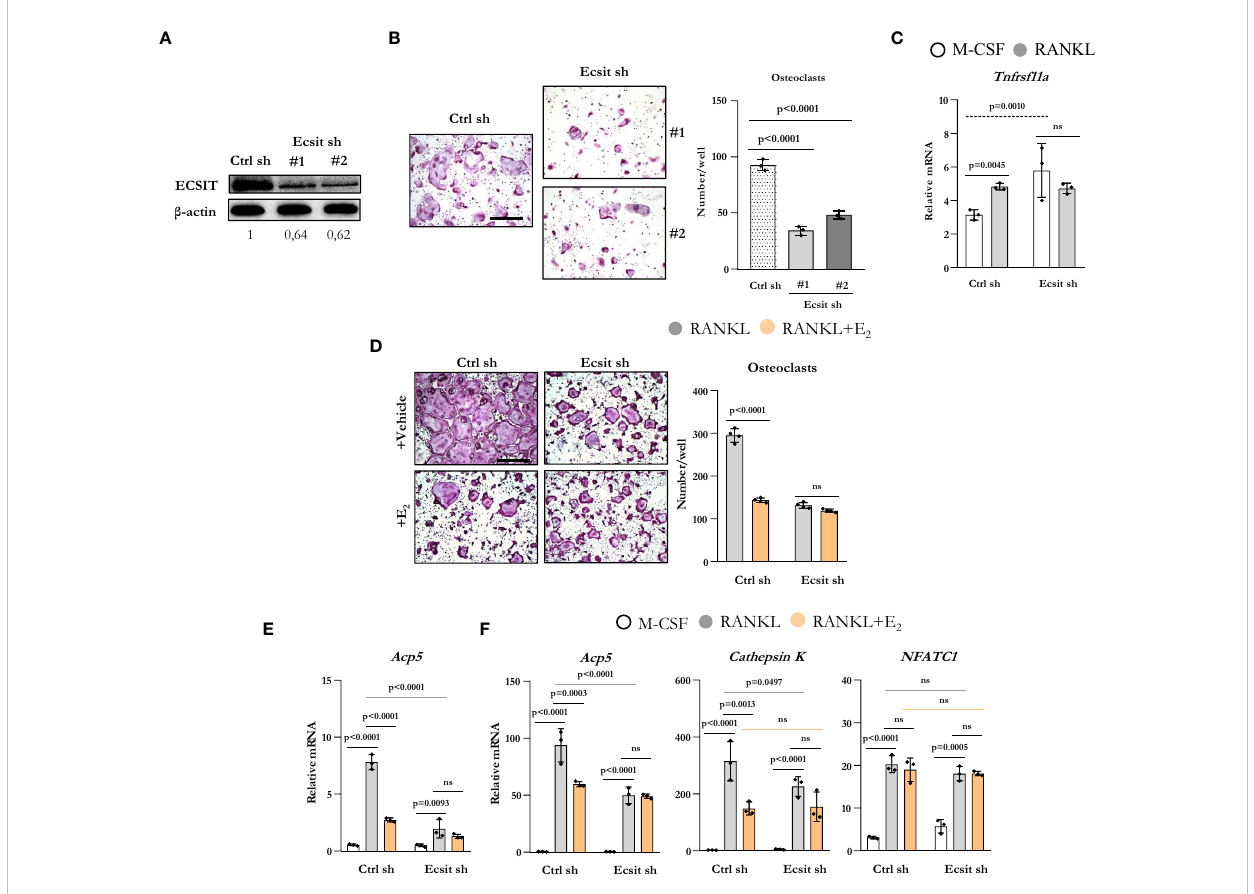
FIGURE 2 Knockdown of ECSIT impairs osteoclastogenesis. BMMs were transduced for 48 h with Ecsit sh (#1 and #2) or unspeci fi c (Ctrl) sh lentivirus particles. (A) ECSIT protein levels in BMMs. (B) Representative pictures and number of TRAP-positive multinucleated osteoclasts in cultures with M-CSF and RANKL for 5 days. Scale bar, 500 m m. (C – F) Cells silenced with Ecsit sh (#2). (C) mRNA by quantitative RT-PCR in cultures treated as indicated for 24 hours. (D) Osteoclastogenesis in as in b in cultures with vehicle or E 2 (10 -8 M). (E) mRNA by quantitative RT-PCR in cultures treated as indicated for 24 hours; or (F) for 3 days. Bar graphs depict mean ± S.D. of 3-4 wells (black dots) of one representative experiment; p values analyzed by 1-way or 2-way ANOVA. ns=not signi fi cant